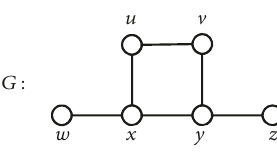
Figure 1: A connected graph 𝐺